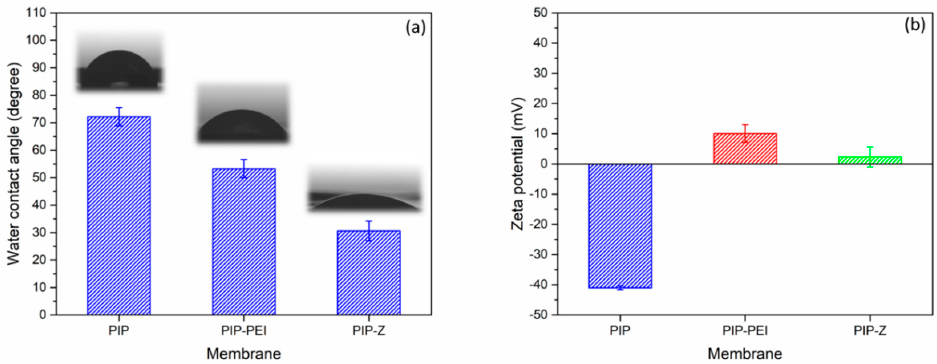
Figure 5. Water contact angle ( a ) and zeta potential ( b ) of TFC NF membrane.